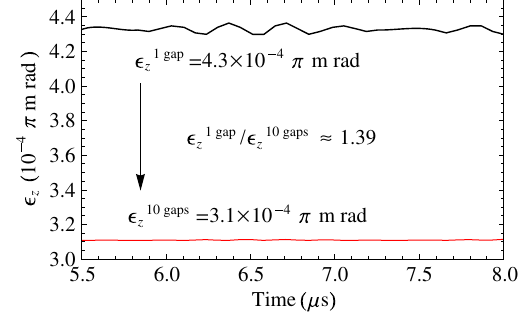
FIG. 3. The red curve shows the unnormalized longitudinal ð t (cid:6) t ¼ 5 : 5 (cid:6) s Þ plot for the whole Rb beam emittance (cid:1) z a accelerated by ten constant voltage gaps. The black curve represents the previous beam accelerated by one constant voltage 1 gap by 1.39 times. gap in Fig. 2(a). (cid:1) 10 gaps z is smaller than (cid:1) z